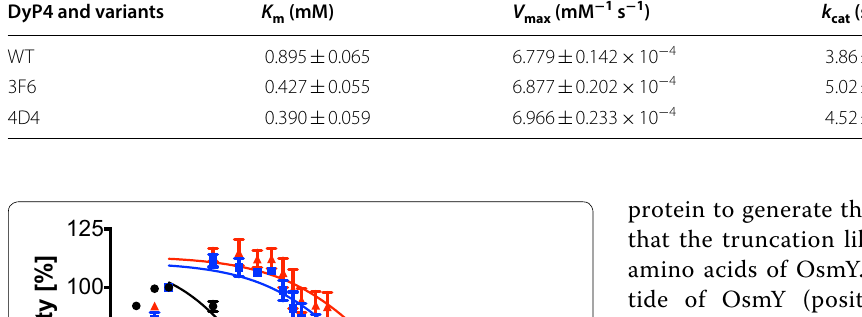
Table 3 Kinetic parameters for ABTS oxidation of DyP4 and its variants DyP4 and variants